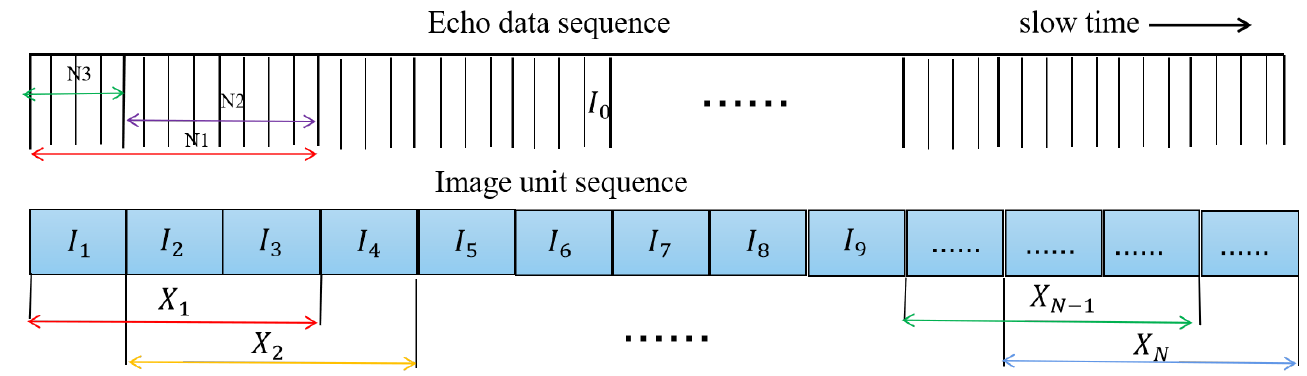
Figure 2. Schematic diagram of generating overlapping image sequence.